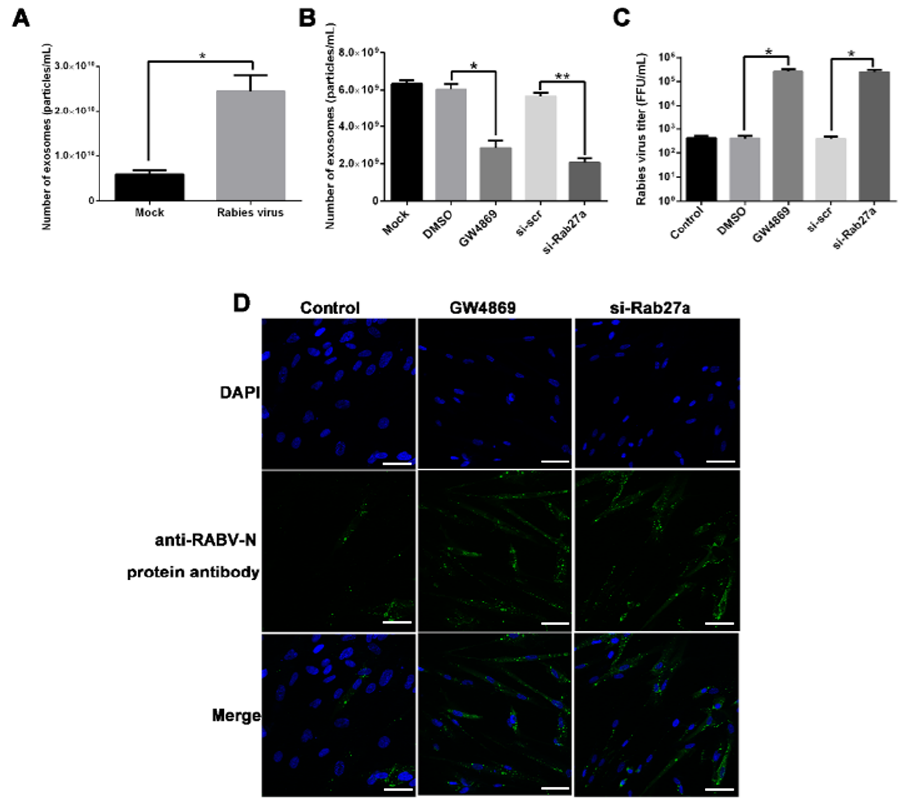
Figure 1. Blocking exosome release promotes rabies virus (RABV) infection in MRC-5 cells. ( A ) Quantification of exosomes from uninfected and RABV-infected MRC-5 cell culture supernatants (48